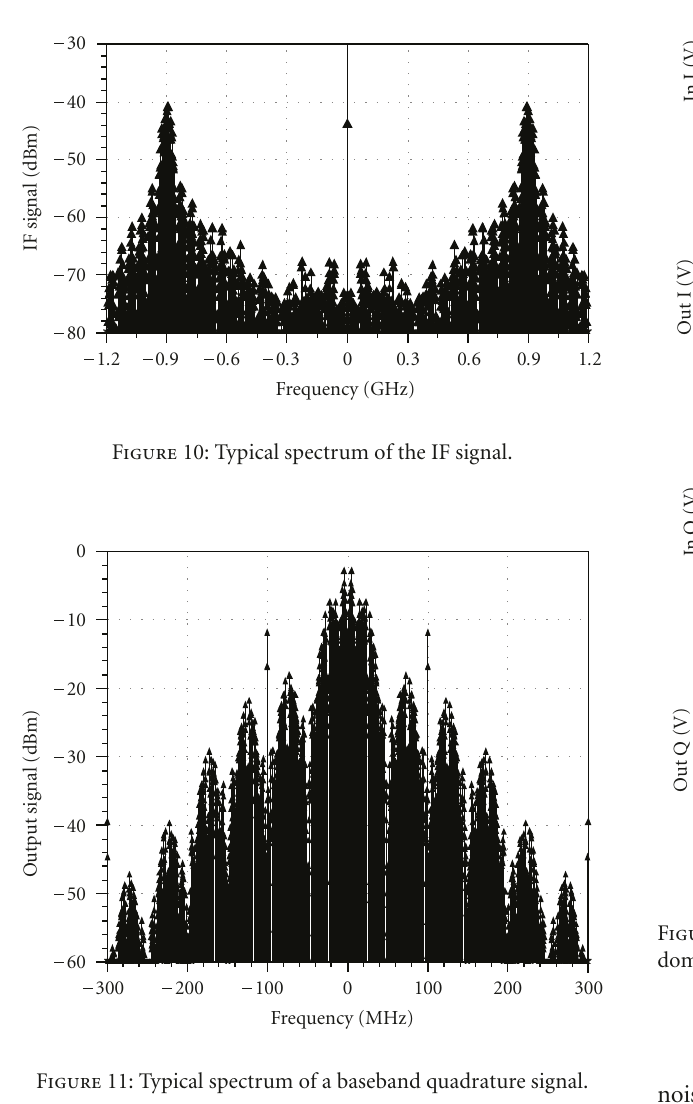
that the spectral lines of of the SHC.